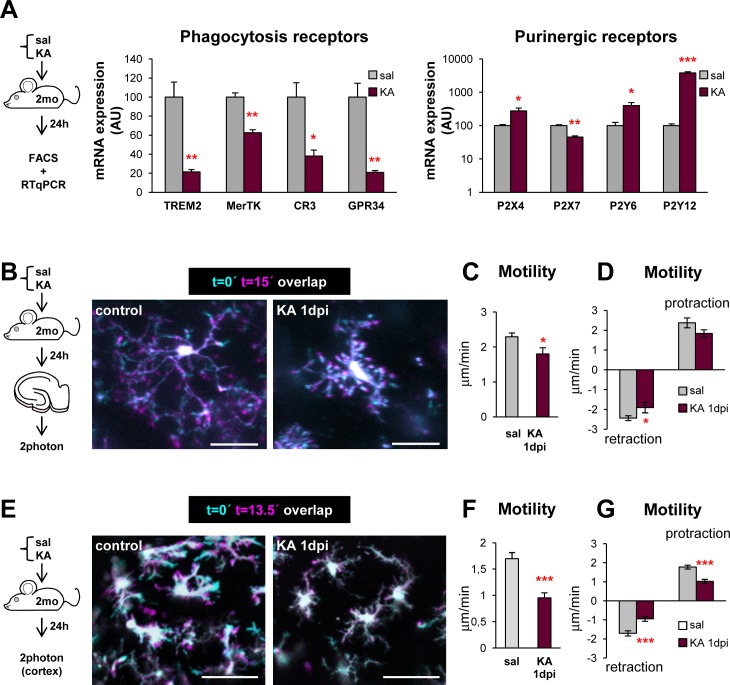
Early phagocytic impairment is related to reduced expression of phagocytosis receptors and reduced motility.(A) Experimental design and expression of phagocytosis and purinergic receptors by RTqPCR in FACS-sorted microglia from control and KA mice at 1 dpi (n = 3 from 8 pooled hippocampi). HPRT was used as a reference gene. (B) Experimental design and representative projections of 2-photon microscopy images of microglia at t0 (cyan) and 15 min later (magenta) from the DG of controls and KA-treated mice (1 dpi). (C) Motility of microglial processes by 2-photon microscopy in acute slices from CX3CR1GFP/+ mice after in vivo injection of KA (1 dpi; n = 4–5 cells from 3–4 mice per group). (D) Retraction and protraction of microglial processes by 2-photon microscopy in acute slices from CX3CR1GFP/+ mice after in vivo injection of KA (1 dpi). (E) Experimental design and representative projections of 2-photon images of microglia at t0 (cyan) and 13.5 min (magenta) in the cortex of controls and KA-treated mice (1 dpi). (F) Motility of microglial processes by 2-photon microscopy in the living cortex of CX3CR1GFP/+ mice after the injection of KA (1 dpi; n = 6 cells from 3 mice per group). (G) Retraction and protraction of microglial processes by 2-photon microscopy in the living cortex of CX3CR1GFP/+ mice after the injection of KA. Bars represent mean ± SEM. * indicates p < 0.05, ** indicates p < 0.01, and *** indicates p < 0.001 by Student´s t test (A, C, D). Scale bars = 20 μm (B), 50 mm (E). z = 50 μm (A), 40 μm (B). Underlying data is shown in S1 Data.